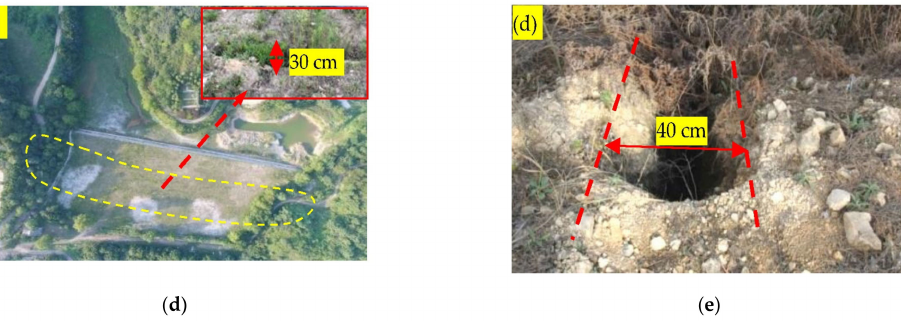
Figure 13. ( a ) Major crack at the east main shaft, ( b ) major crack near the east main shaft, ( c ) distribution of cracks in the area near the east main shaft, ( d ) major crack near the flood-control dam, and ( e ) major crack near the west ventilating shaft.